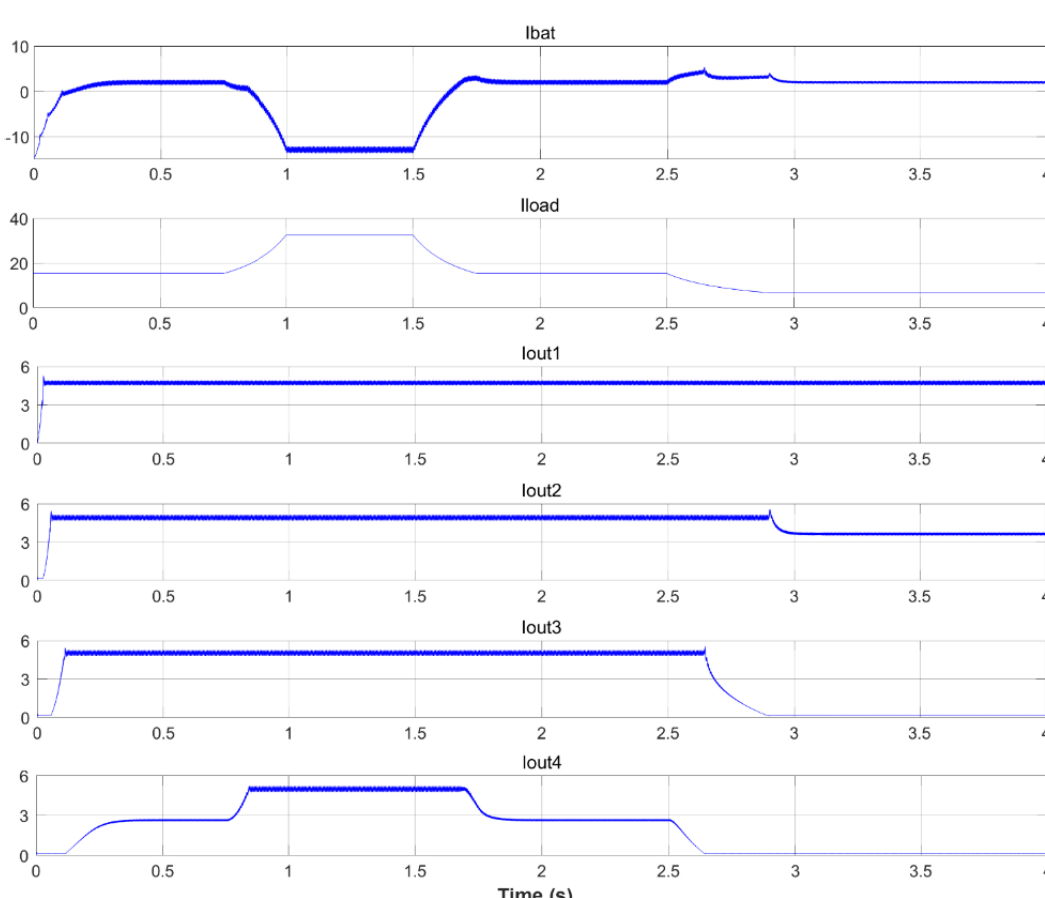
Figure 14. Waveforms provided by the Simulink model of the SMPT technique: Ibat: battery current; Iload: load current; Iout n with n = 1 to 4: output current of APR n . All currents are in amperes.